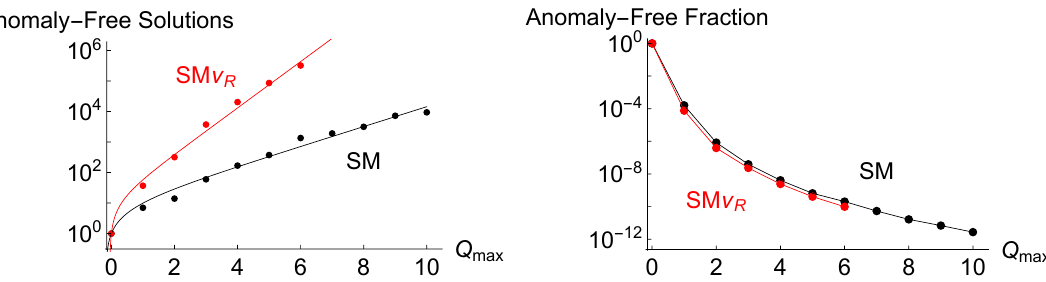
Figure 1 . Left : the total number of inequivalent anomaly-free solutions with a given Q max , as tabulated in tables 2 and 3, together with the functions 8 e 3 x= 4 (cid:0) 7 and 12 e 7 x= 4 (cid:0) 11 which roughly \(cid:12)t-by-eye" the growth of the number of solutions. Right : the fraction of all inequivalent charge assignments which is anomaly free for a given Q max , showing that imposing anomaly-freedom can lead to a drastic reduction in the available parameter space.